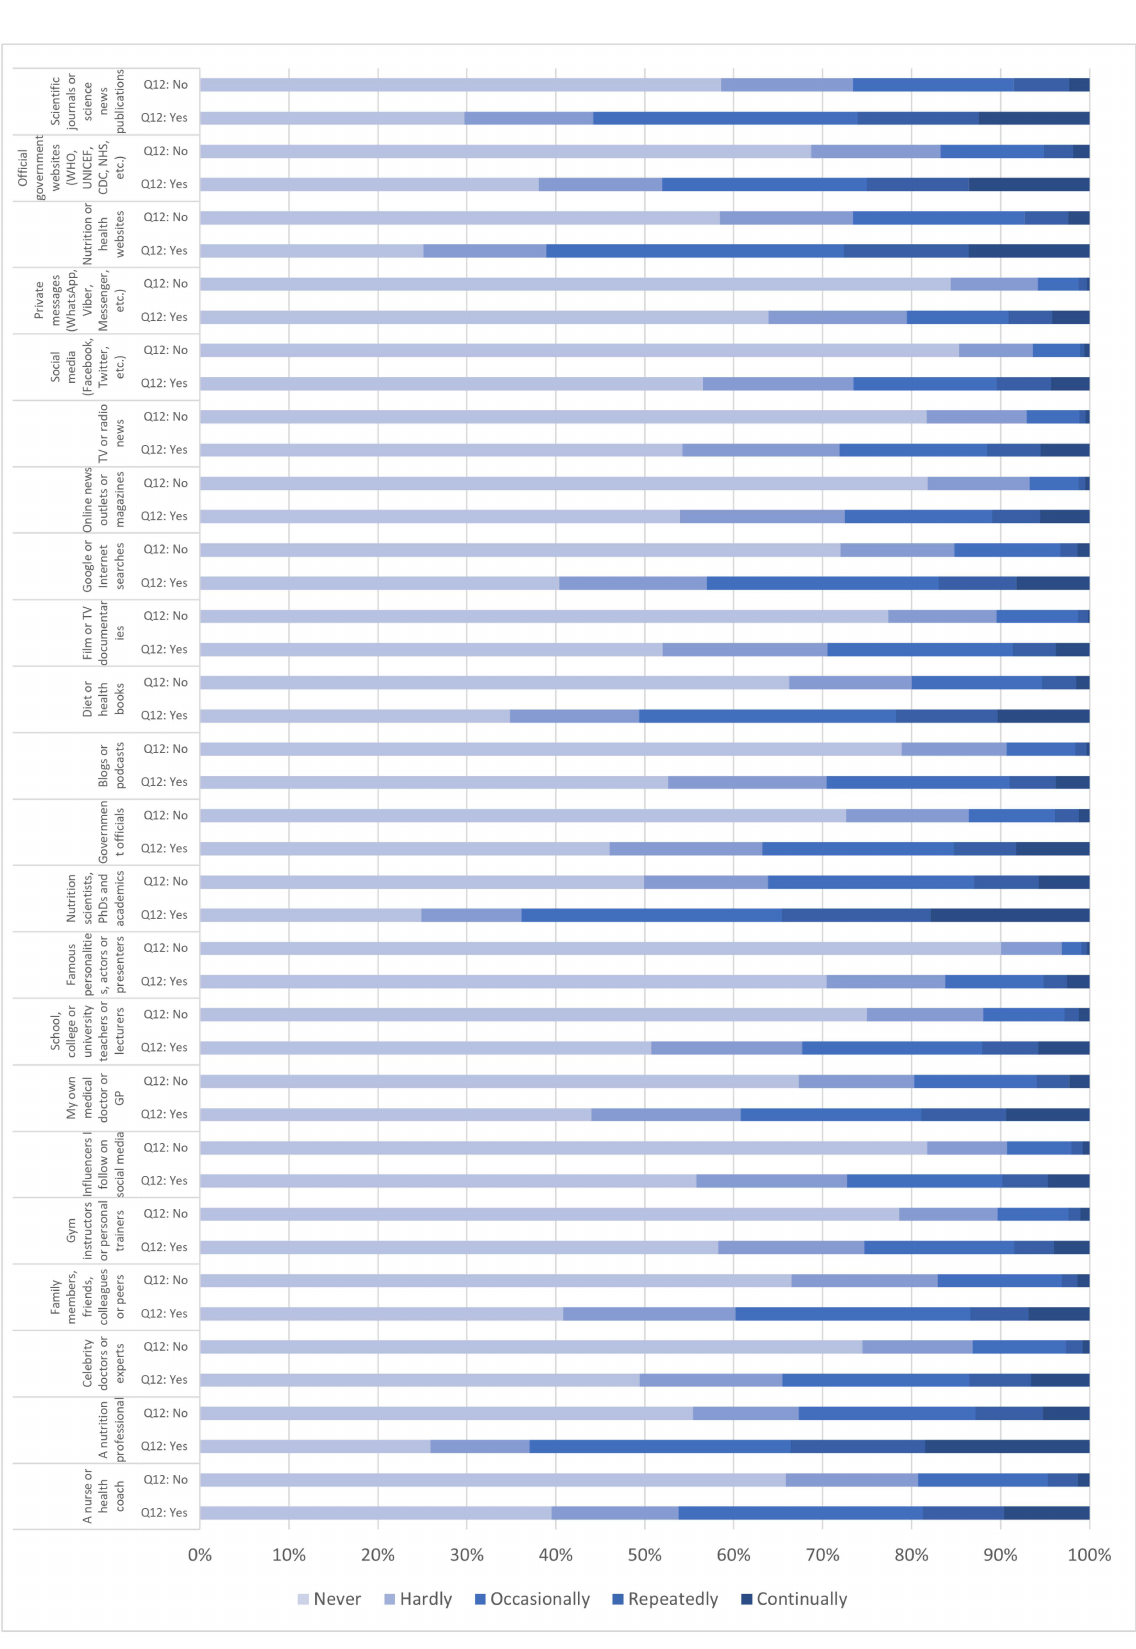
Figure 1. Comparison of dietary change frequencies per source between participants with increased (‘yes’) and no increased (‘no’) interest in nutrition since the start of the COVID-19